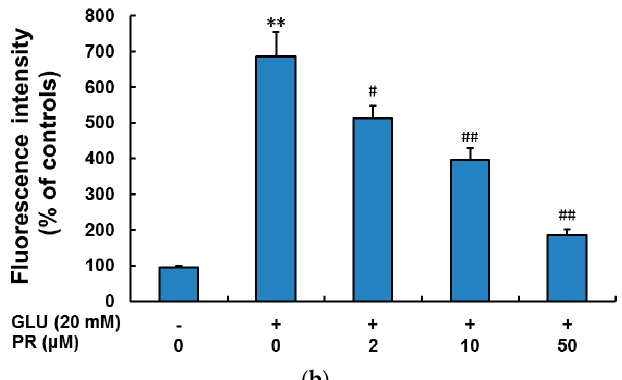
Figure 3. The neuroprotective effect of puerarin against the glutamate-induced Ca 2+ influx in the differentiated Y-79 cells. Cells were pre-treated with puerarin (0, 2, 10 and 50 μ M) for 24 h and then exposed to 20 mM glutamate for 12 h. After treatment, cells were incubated with Fluo-3/AM working solution at 37 °C for 30 min in dark. ( a ) Representative microphotographs of fluorescence staining; ( b ) the relative fluorescence intensity was analyzed by microplate reader. All data were expressed as mean ± SD of three experiments and each experiment included triplicate repeats. ** p < 0.01 vs. control group; # p < 0.05, ## p < 0.01 vs. glutamate-treated group. GLU: glutamate, PR: puerarin.